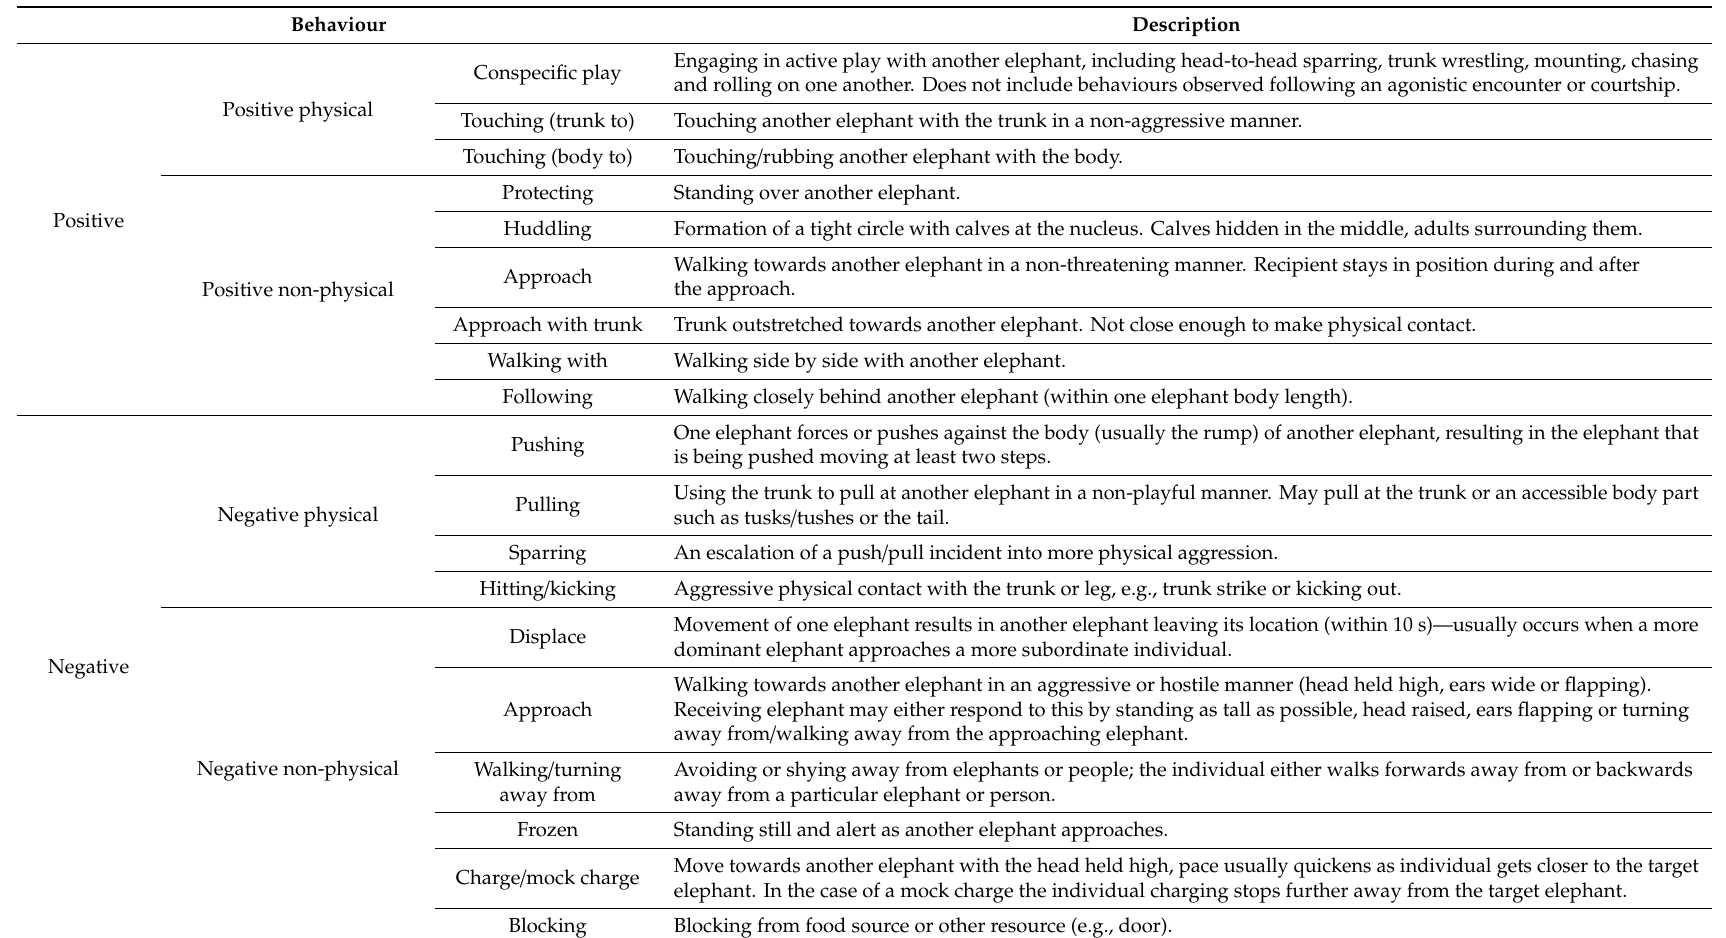
Table 2. Elephant behaviour ethogram (based on Asher et al. [31]) [50].